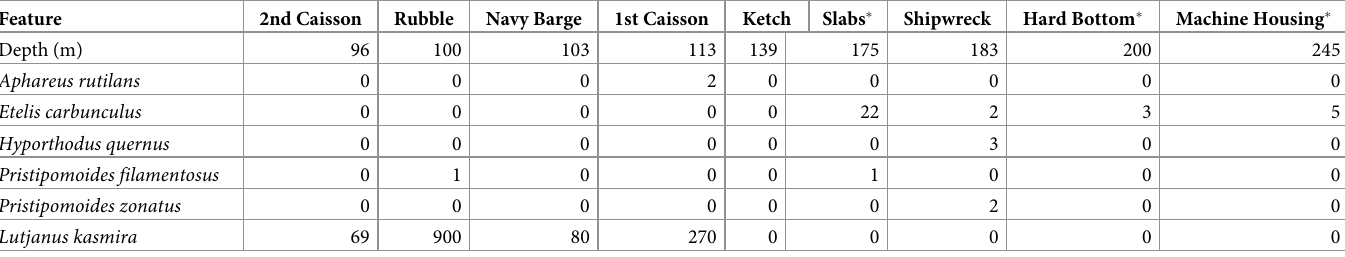
Table 3. Abundances of the ‘Deep 7’ and L . kasmira . Features marked with an asterisk were only surveyed once.